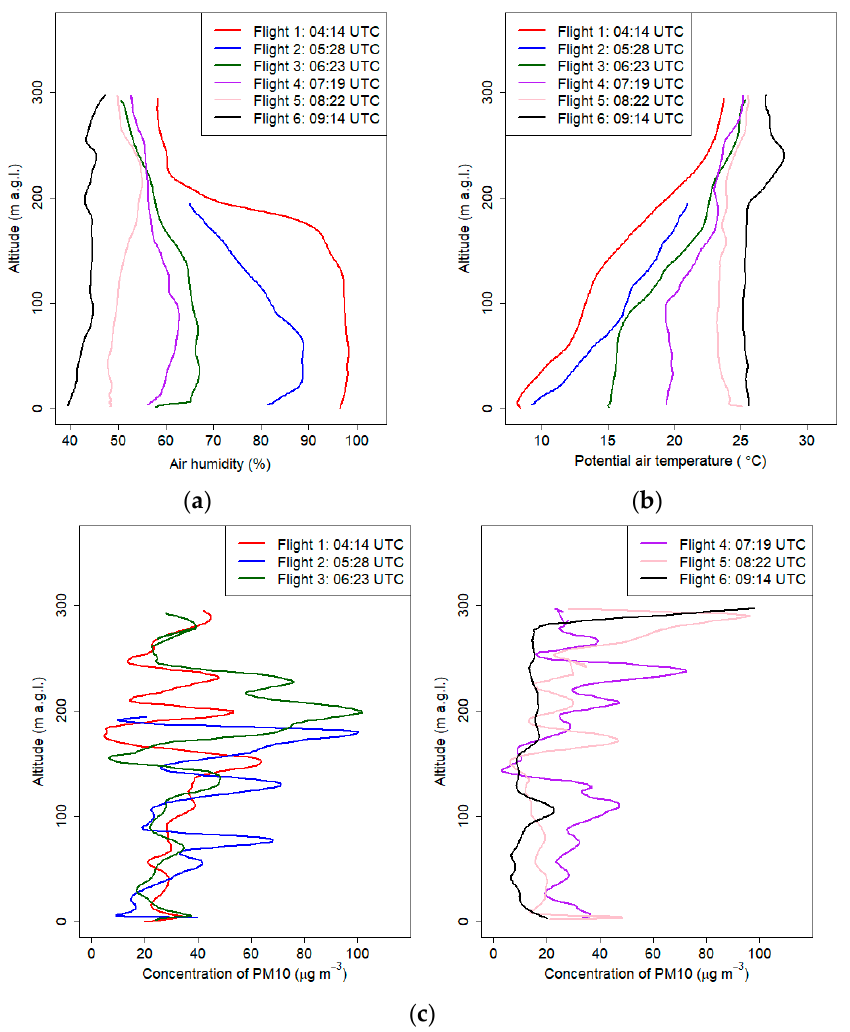
Figure 12. Vertical profiles of relative humidity ( a ), potential air temperature ( b ) and PM 10 concentration ( c ) on 21 September 2018 from 4:00 UTC to 12:00 UTC.